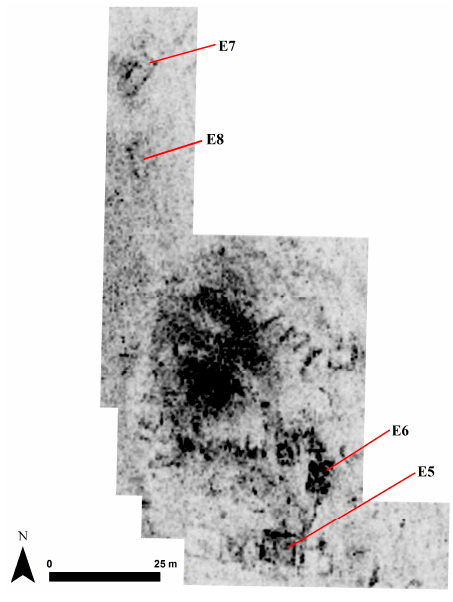
Figure 22. GPR survey results from Perdika 2 at 90–100 cm depth. Darker colors indicate high reflectance anomalies.